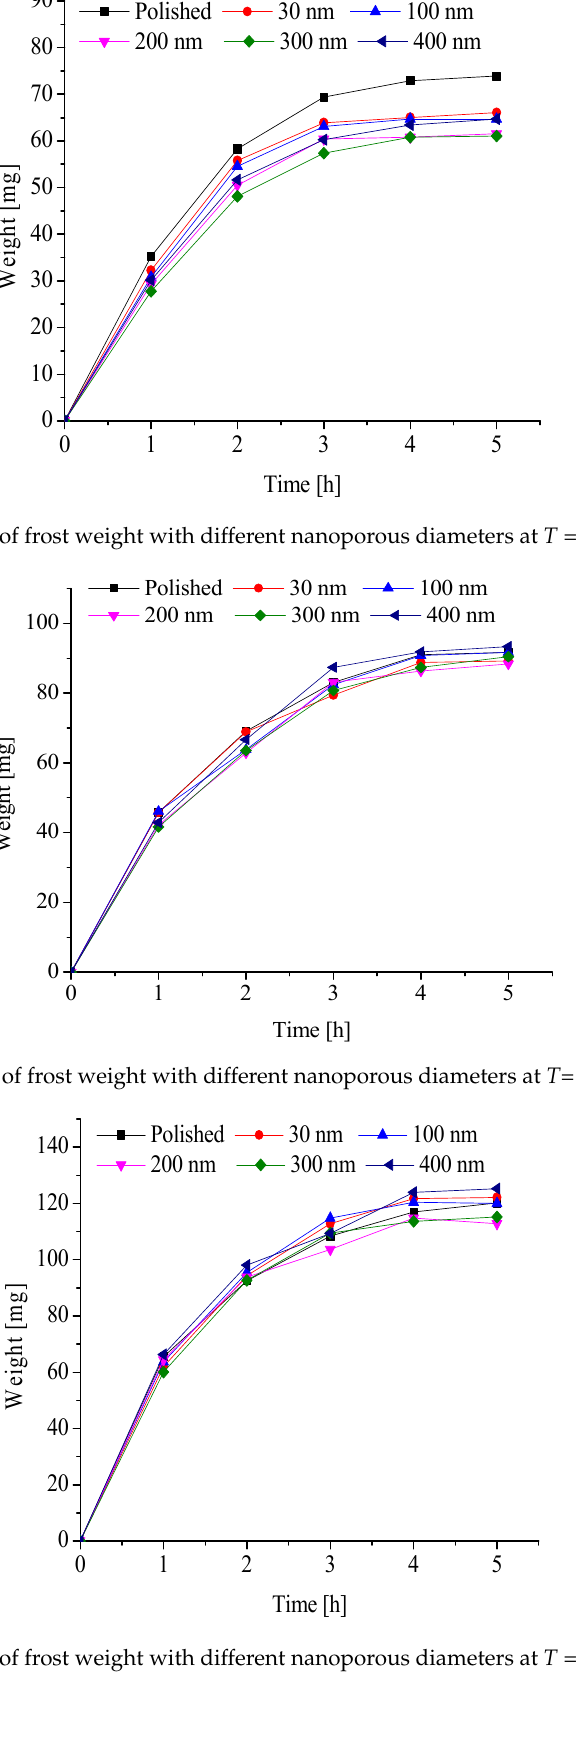
Figure 20. Variations of frost weight with different nanoporous diameters at T = − 25 °C, φ = 90%.